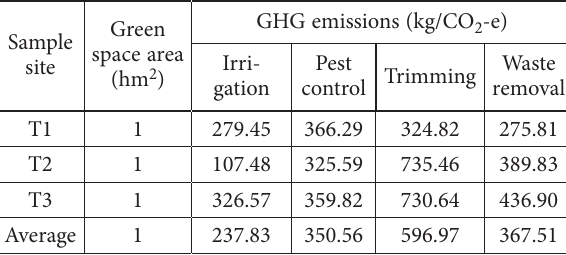
Table 7. GHG emissions from the various maintenance tasks in the traditional cemetery green space